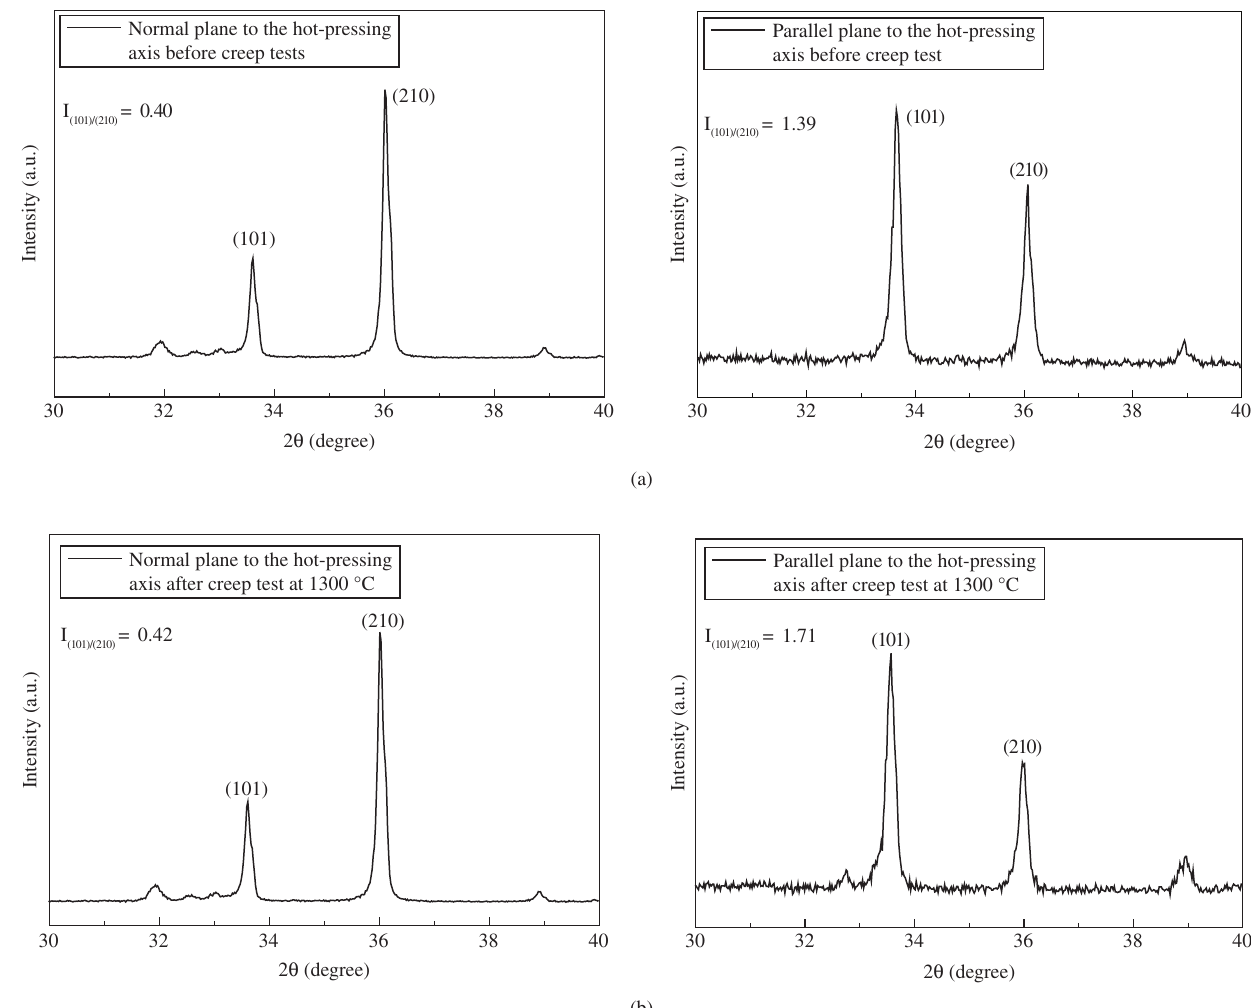
Figure 4. X ray diffraction patterns of the specimens: a) before he creep tests, in perpendicular and parallel planes to the hot pressing axis; and b) after creep tests at 1300 °C and 300 MPa, in planes (N) and (P).